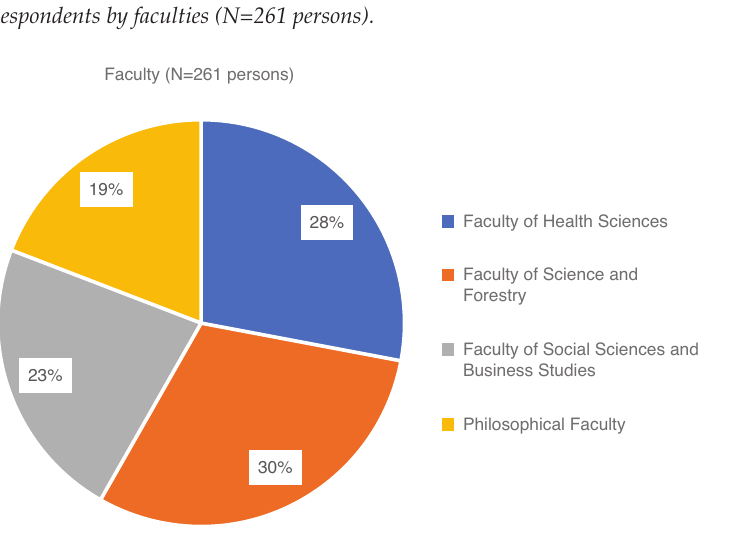
Fig. 2: Respondents by faculties (N=261